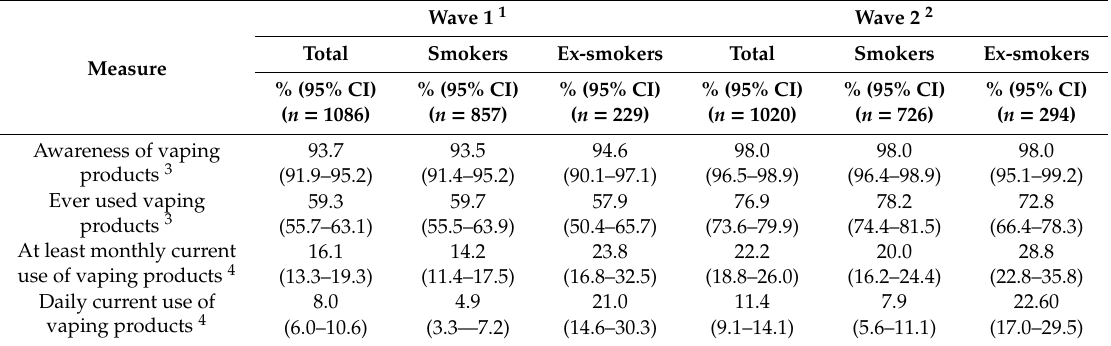
Table 2. Prevalence of awareness and use of e-cigarettes in Waves 1 and 2 stratified by smoking